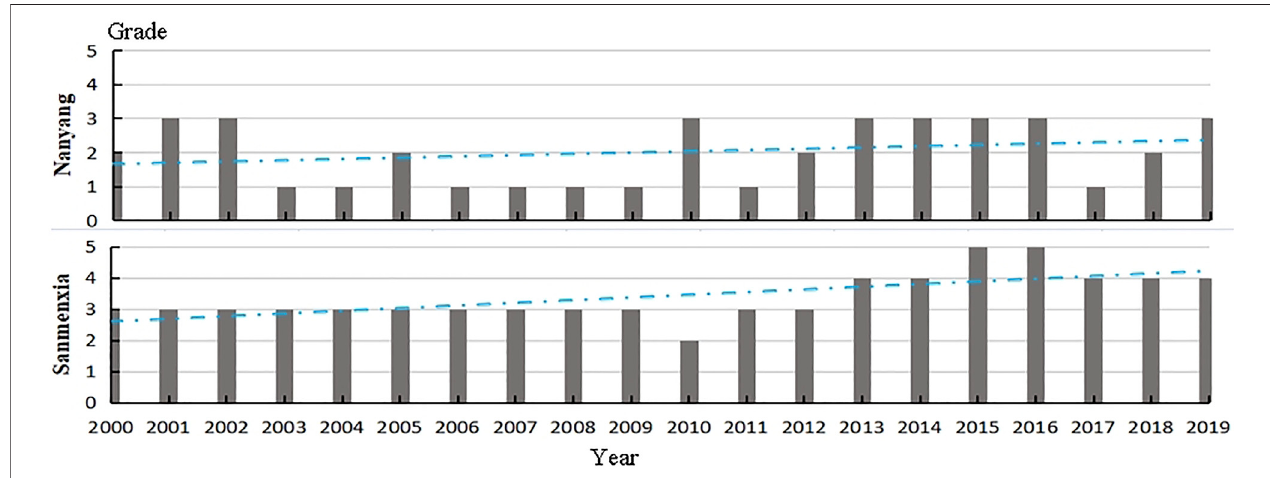
FIGURE 7 | Evaluation results of water resources value in Henan province.